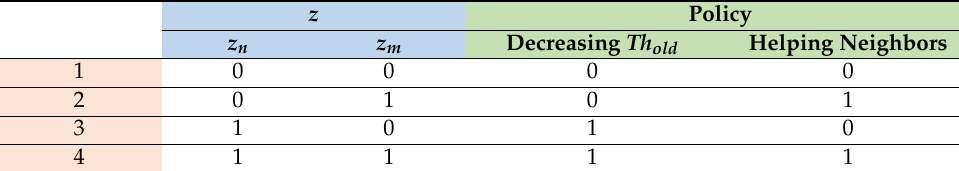
Table 1. Learning policy.